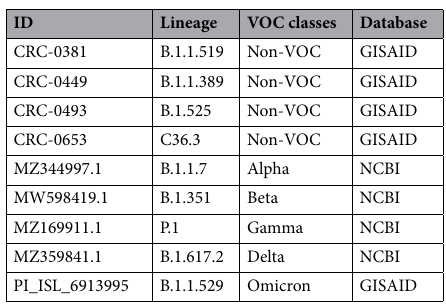
Table 1. SARS-CoV-2 sequences used to build the custom database to classify genome sequences into VOC categories based on ASV calling analysis.